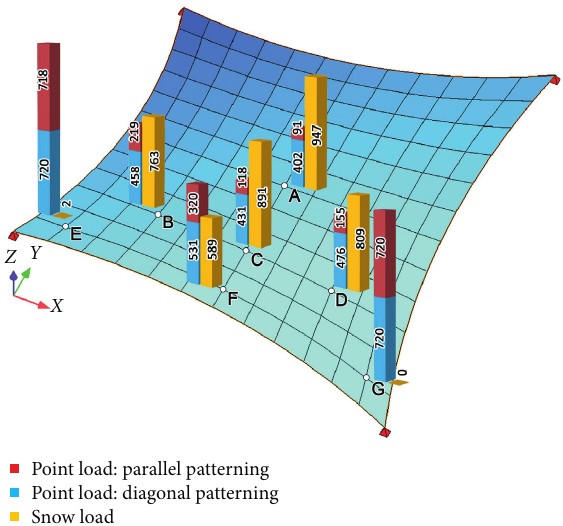
Figure 10: Number of models sorted according to higher de- flections at analysed